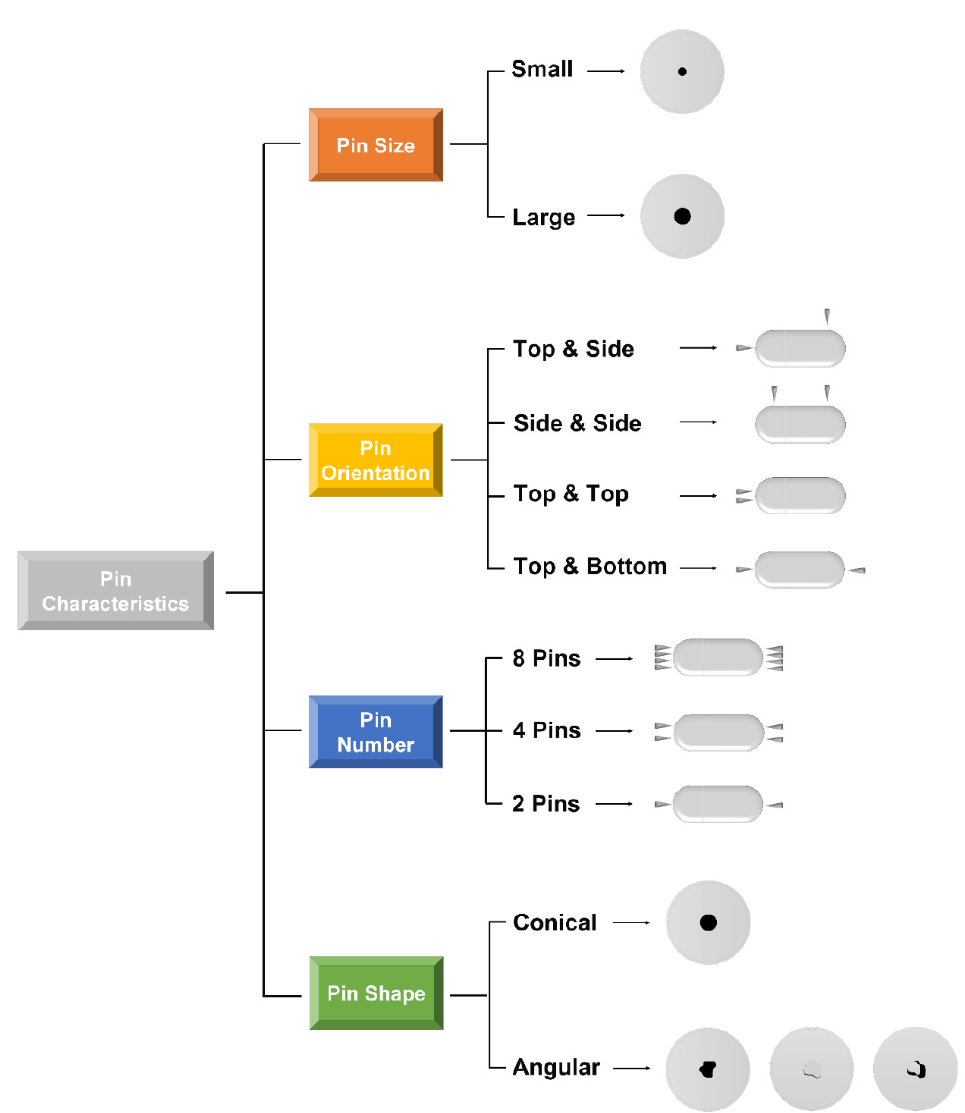
Figure 5. The pin characteristics category within pin activated cDPIs and their outcome on capsule appearance after piercing.